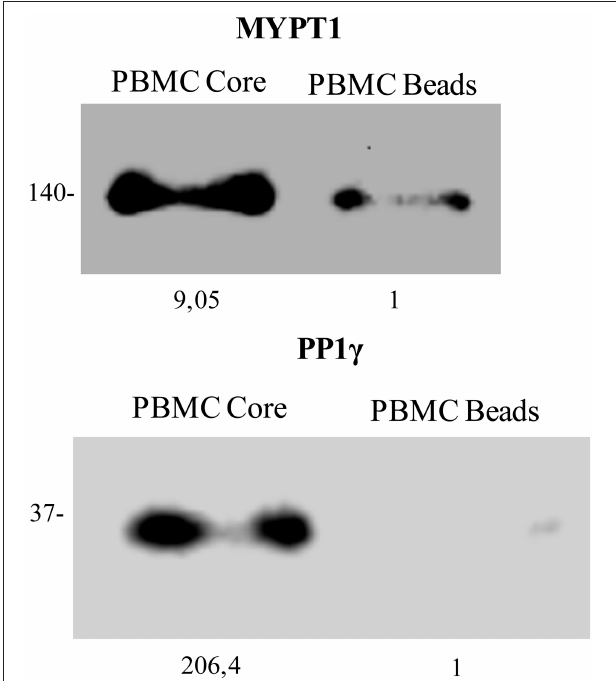
FIGURE 4 | HCV Core protein interacts with PP1 γ and MYPT1 in PBMC blasts. Postnuclear lysates from Human PBMCs stimulated with PHA and cultured during 5 days with IL-2, were subjected to HCV Core protein pull down. Proteins pulled down by HCV Core coated magnetic beads (PBMC Core band) or by uncoated magnetic beads (PBMC beads band) were analyzed by Western blot with anti-human MYPT1 (A) and anti-human PP1 γ (B) . Molecular mass, in kDa, is indicated on the side and band quantitation at the bottom for each Western